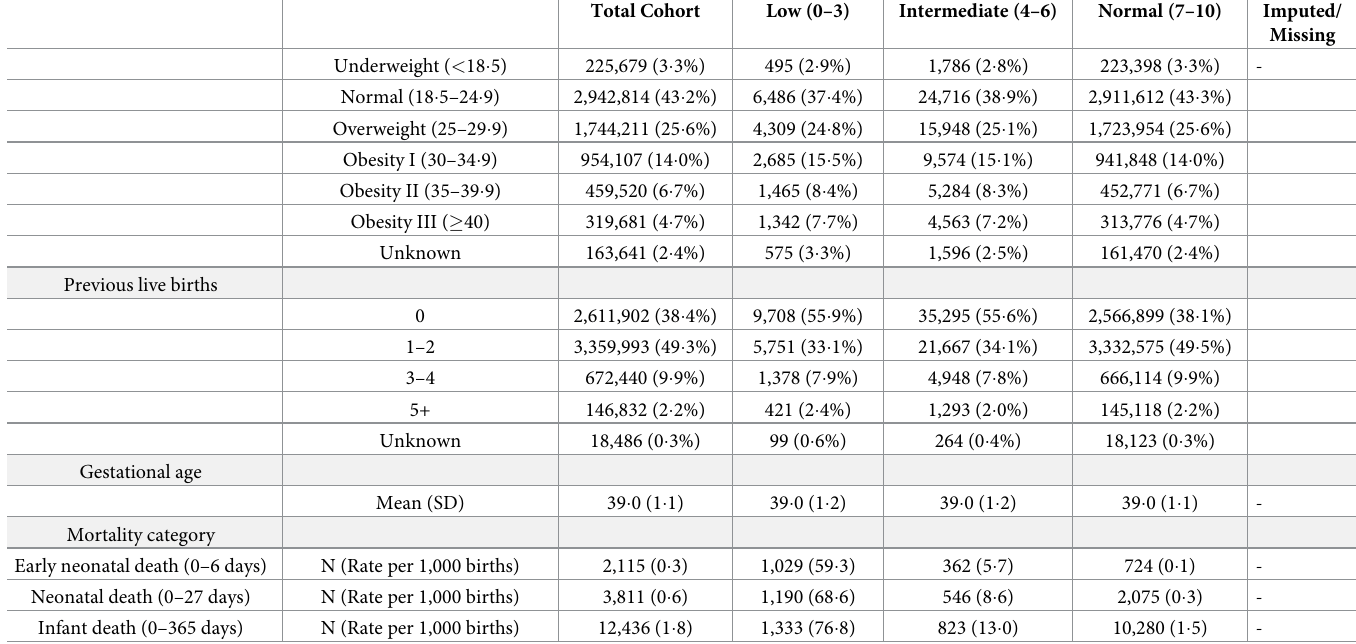
evidence of a difference in early neonatal mortality between non-Hispanic other and white infants, but non-Hispanic other infants had higher odds of neonatal and infant mortality.